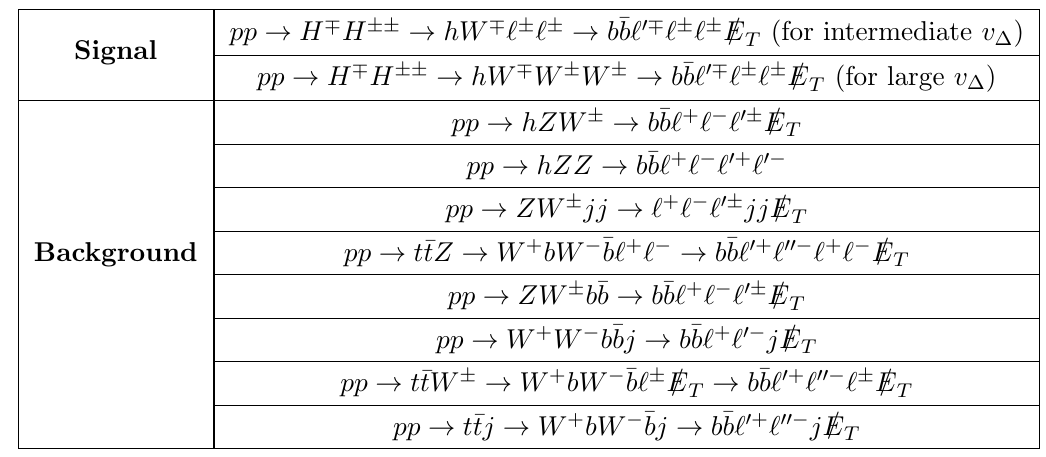
Table 3 . Signals for intermediate and large v (cid:1) are listed in the (cid:12)rst two rows. The two signals share the same backgrounds, which are listed in the following eight